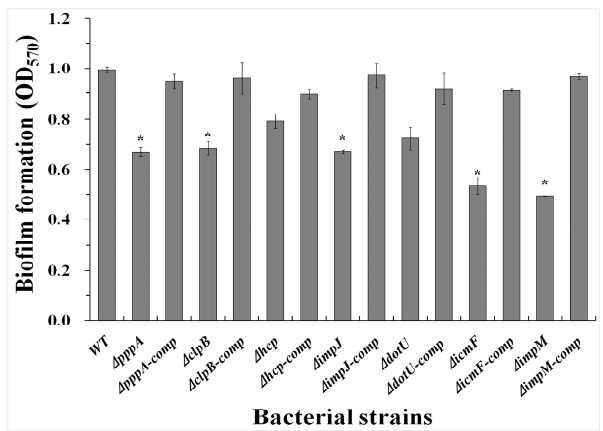
Figure 7. Quantification of biofilm produced by the wild-type, the T6SS mutants and the corresponding complemented strains of Acidovorax avenae subsp. avenae strain RS-2. Means ± SEM are shown ( n = 6). Vertical bars represent standard errors of the means. Asterick indicated significant difference between the wild-type strain and the T6SS mutants, or the complemented strains (* 0.01 < p < 0.05).